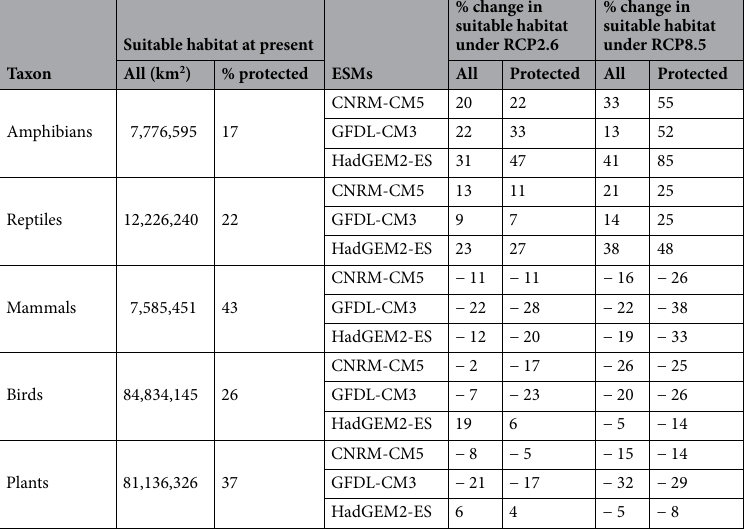
Table 3. The extent of suitable habitat for species within protected areas in Thailand currently and projected for 2070 for five taxa using three earth system models and two RCPs.